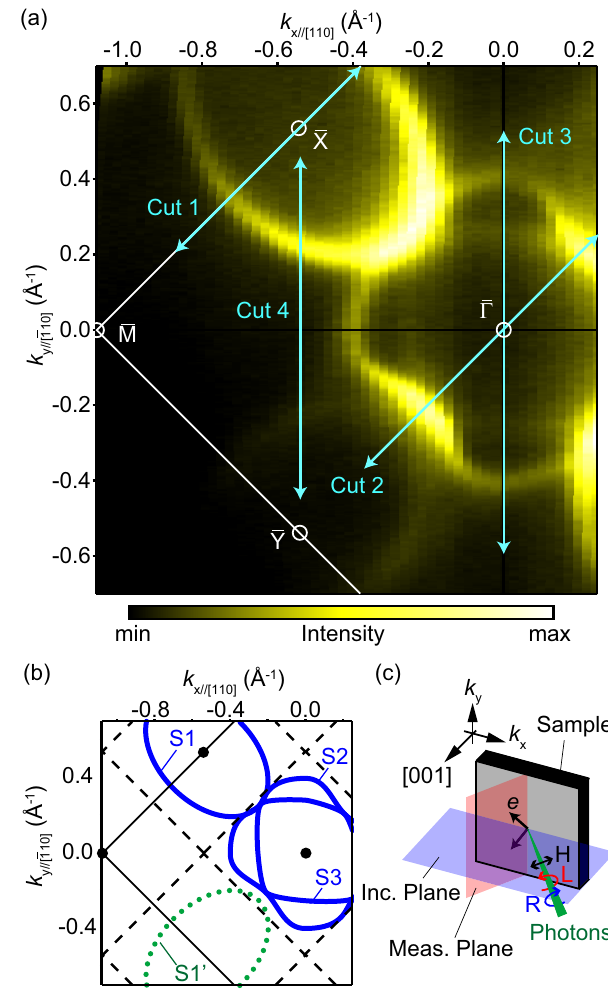
Fig. 2 | Fermi contours (FCs) obtained by ARPES. a ARPES FCs taken with circu- larlypolarizedphotons( h ν =35eV)at13K.TheARPESintensitiesfromtheleft-and right-handed polarizations are summed up to show all the states without any in fl uenceofcirculardichroism(CD).Thephoton-incidentplaneis( (cid:1) 110).Thearrows indicate the positions where the E - k dispersions shown in Figs. 3, 4, and Supple- mentary Fig. 1 were taken. b Schematic drawing of the observed FCs together with the border of surface Brillouin zones; solid lines for bulk-truncated (1×1) and dashed for (2×2). c Experimental geometry and de fi nition of the in-plane wave- vectors k x and k y . k x and k y are always in the photon-incident and photoelectron detection planes, respectively. In this work, two cases, the incident planes of (010) and ( (cid:1) 110) were measured. The relationship between k x , y and the crystal orientation is shown by subindexes such as k y == ½ (cid:1) 110 (cid:2) and k y //[010]